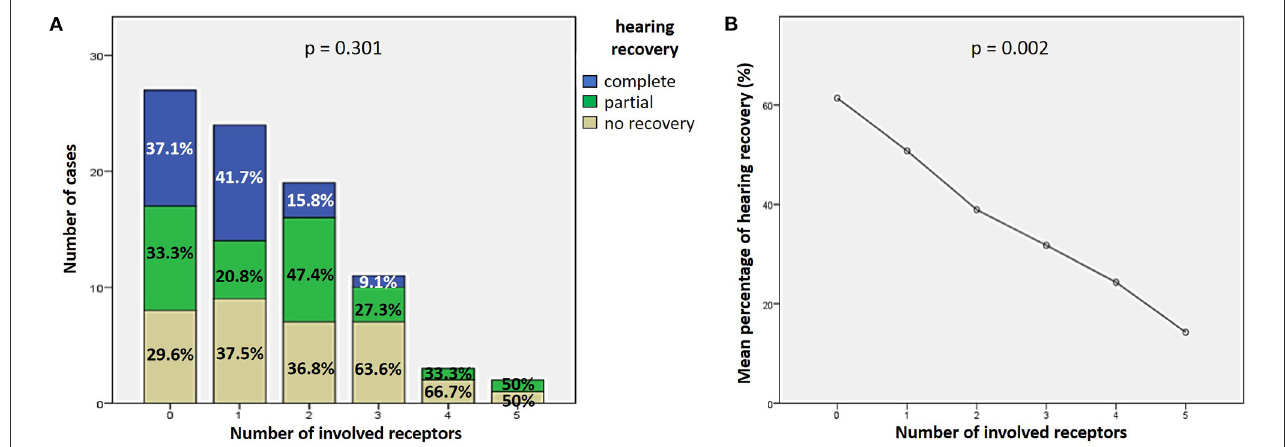
FIGURE9 Correlation between the number of impaired vestibular receptors ipsilesionally to SSNHL and hearing recovery. (A) Bar plots showing the different distribution of hearing recovery among the study cohort divided according to the number of affected sensors. (B) Correlation trend between the number of impaired vestibular receptors and mean percentage of hearing